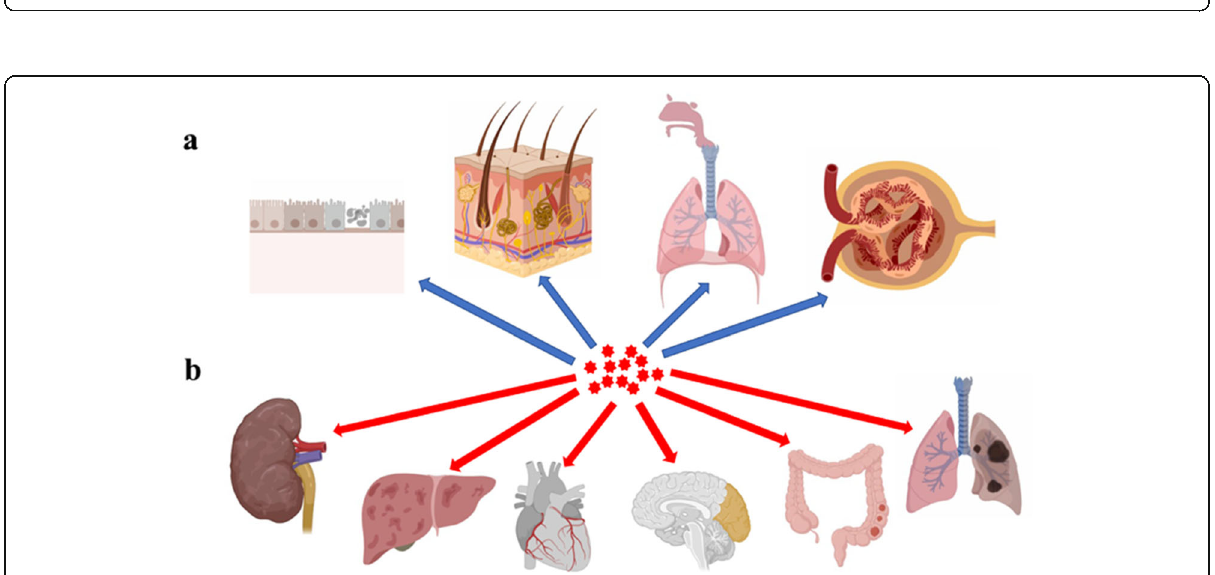
Fig. 4 NP entrance into and damage of organs. a NPs could enter into the organisms through the oral cavity, nasal cavity, respiratory tract, kidneys, and intestinal tract; b NPs could spread by systemic circulation and accumulate in the kidneys, liver, heart, brain, intestinal tract, and lungs, leading to organ dysfunction (This figure was created in BioRender.com).